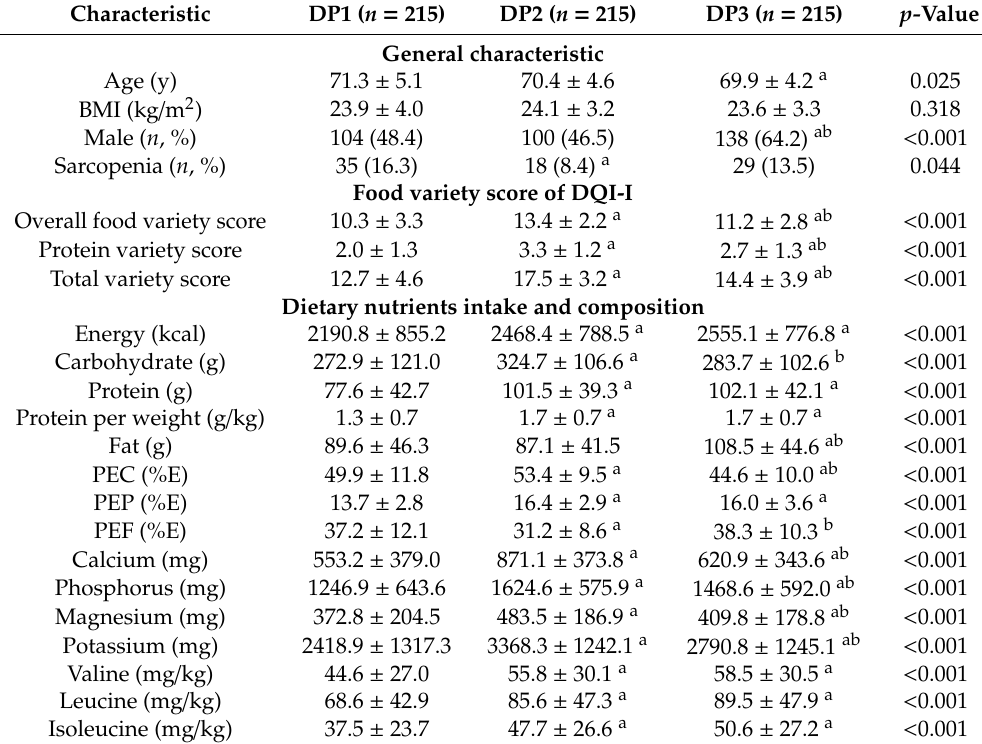
Table 5. Di ff erent food variety and nutrients intake among the highest quartiles of three DPs. Characteristic DP1 ( n =